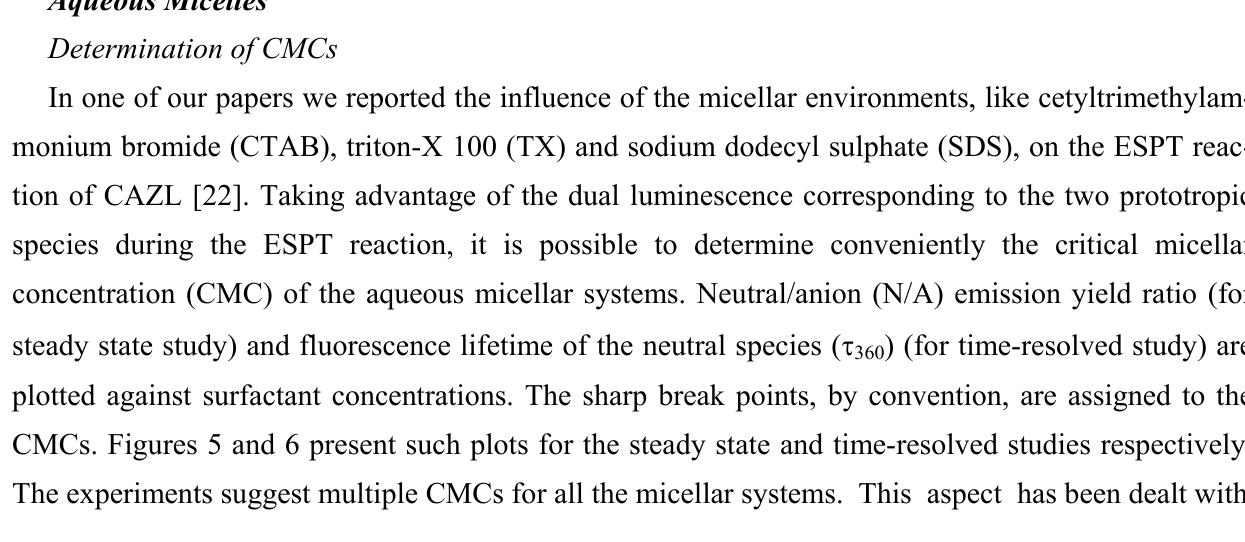
Figure 4. Plots of k vs. T/ η for different experimental sets of ESPT reactions. Top to bottom 1 represents IND-NaOH, DPA-NaOH, CAZL-NaOH, CAZL-Et CAZL-NH (all are in aqueous solutions, η at different temperatures have been taken from CRC 3 Handbook of Chemistry and Physics , 67 th Edn., 1986, F-37 and